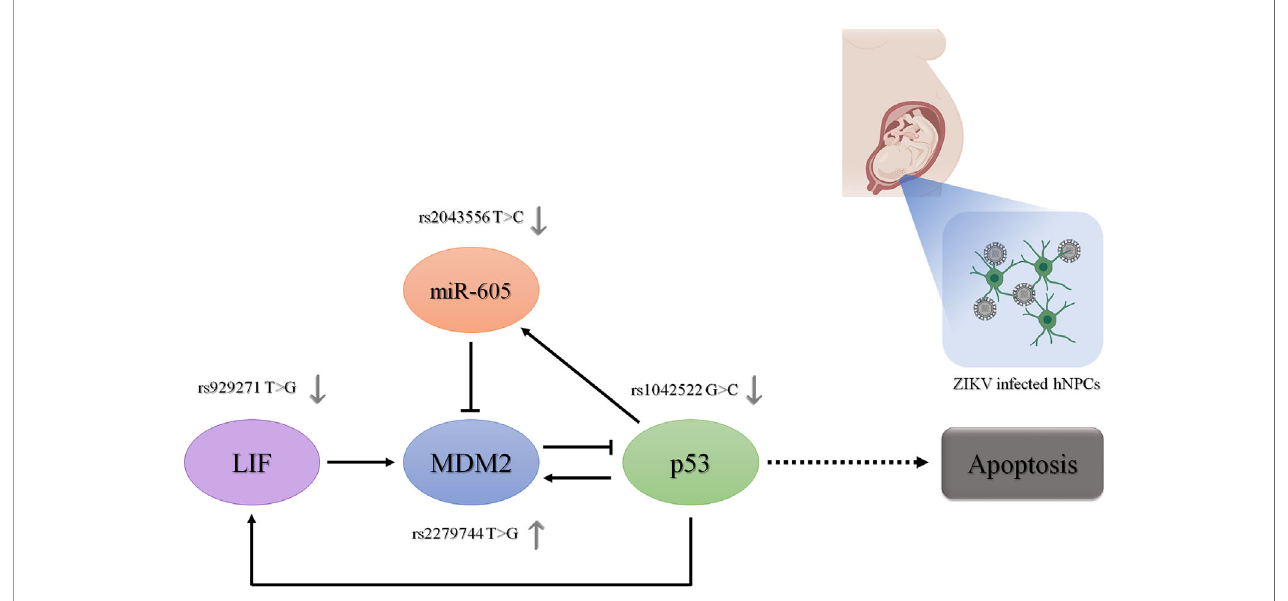
FIGURE 2 | Role of the investigated genes and their functional polymorphisms in the p53 signaling pathway. The regulatory role of the proteins encoded by these genes in the expression of the other genes in the p53 signaling pathway is represented by dark arrows. The regulatory role of the polymorphisms in their gene expression is represented by gray arrows. Ultimately, the effect of these genetic variants on p53 expression levels and activity in the context of human neural cells infected by ZIKV is represented. hNPCs, human neuroprogenitor cells. Created in BioRender.com.